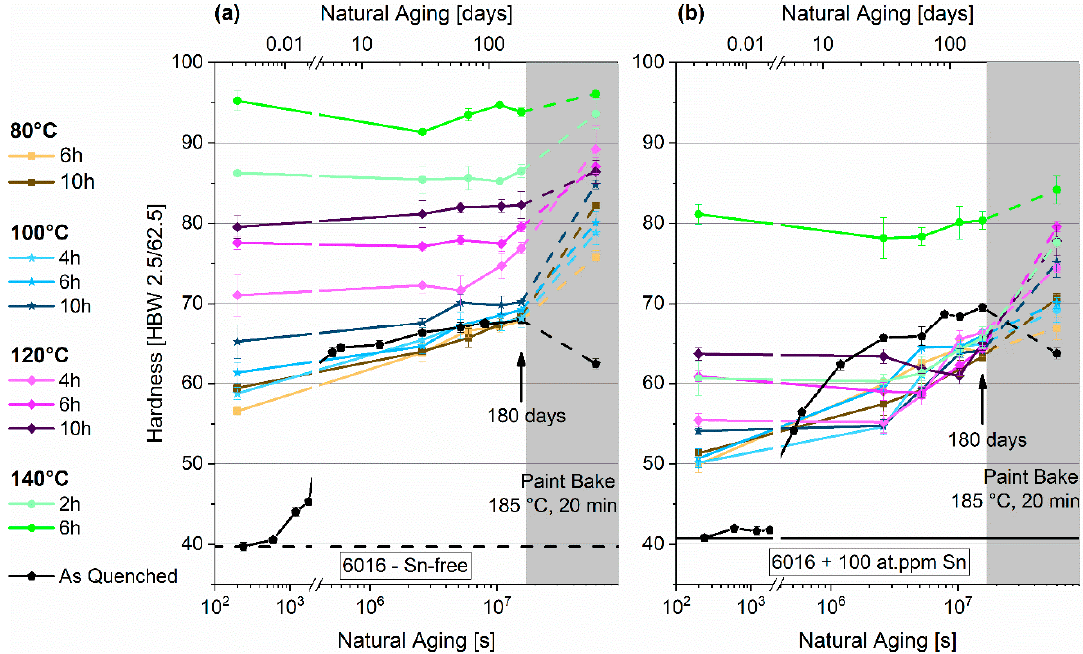
Figure 4. Natural aging behavior of samples treated according to PA1 for EN-AW-6016 Sn-free ( a ) and EN-AW-6016 + 100 at.-ppm Sn ( b ). The shaded areas show the hardness evolution during paint-bake treatment (185 °C, 20 min, no pre-deformation).